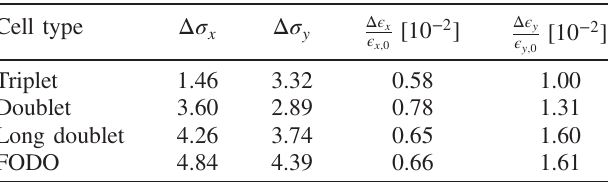
TABLE VI. Maximum and minimum rms beam size and relative emittance growth in mm for triplet, doublet, long doublet and FODO lattice, where the notation Δ σ x=y ¼ σ x=y; was used. The beam size has been calculated using the design transverse normalized rms emittance of 2 . 5 μ m and the rms momentum spread corresponding to the design longitudinal emittance of 2.8 eVs.